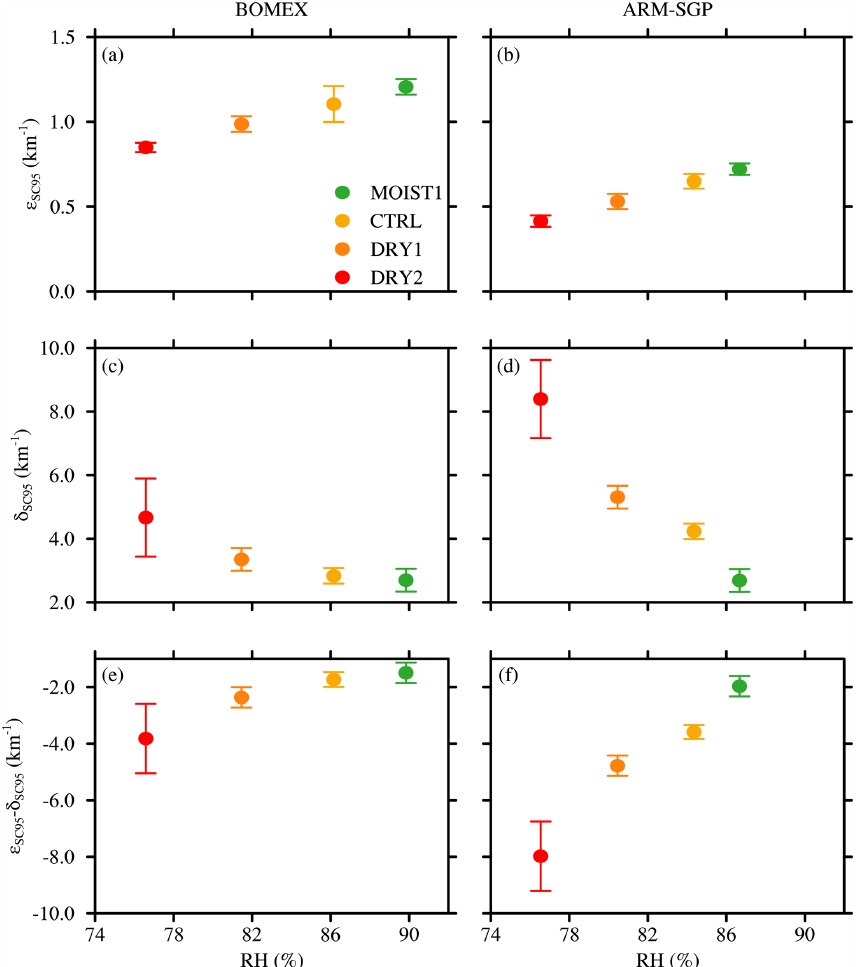
Figure 3. Variation of mean (a–b) fractional dilution rate ( ε ), (c–d) fractional detrainment rate ( δ ), and (e–f) the difference of fractional dilution and detrainment ( ε − δ ) as a function of cloud-layer RH (vertically averaged over the central 50% of the cloud layer). Panels (a) , (c) , and (e) show the maritime BOMEX case, and panels (b) , (d) , and (f) show the continental ARM-SGP case. The error bars indicate the width of twice the standard deviation of the